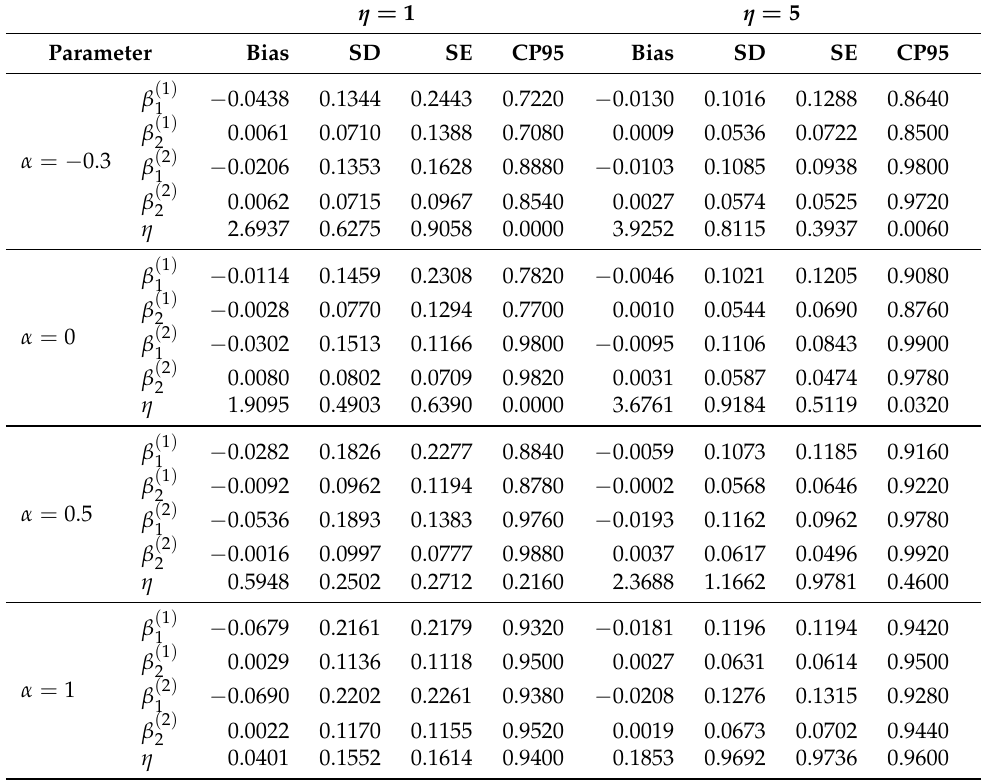
Table A3. Simulation results: estimation of regression coefficients and η from the naive method for data generated with different α values and true β Bias refers to the difference between the average of the 500 posterior means and the true value; SD refers to the mean of the 500 posterior standard deviations; SE refers to the standard deviation of the 500 posterior means, and CP95 refers to the 95% coverage probability.